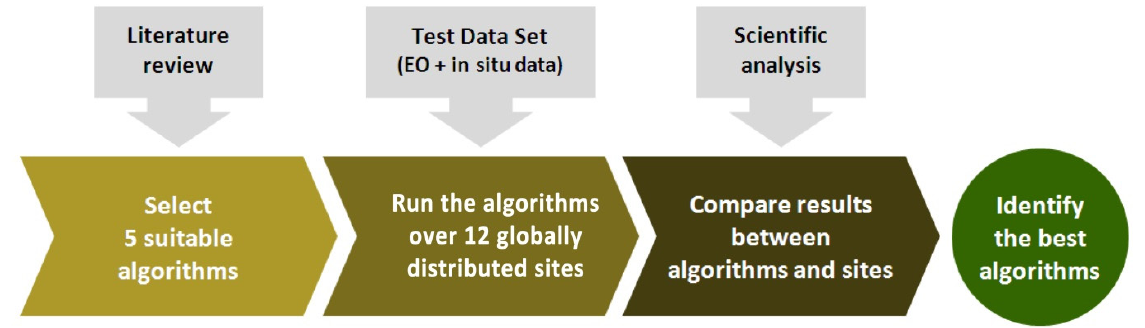
Figure 2. Overall concept of the benchmarking concept.